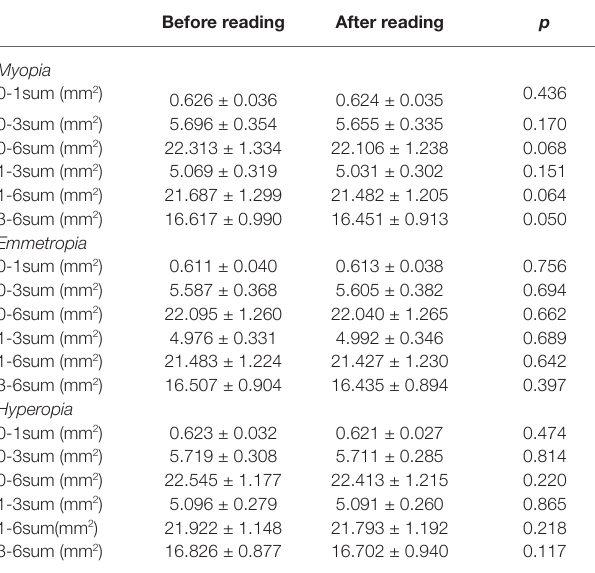
TABLE 7 | Comparisons of choriocapillaris luminal area (CLA) before and after accommodation in myopia, emmetropia and hyperopia groups. Before reading After reading p